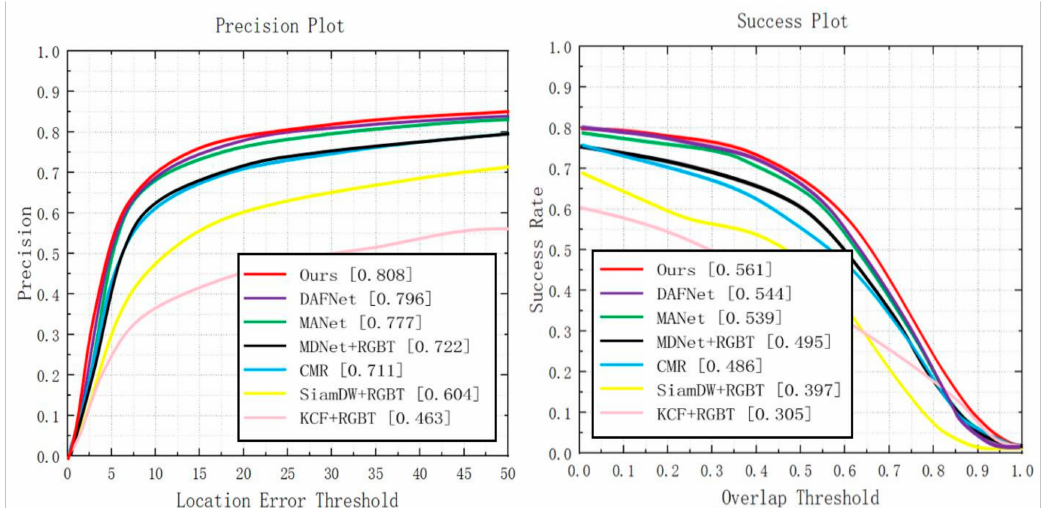
Figure 7. Comparison results with the current state-of-the-art methods on GRBT234.